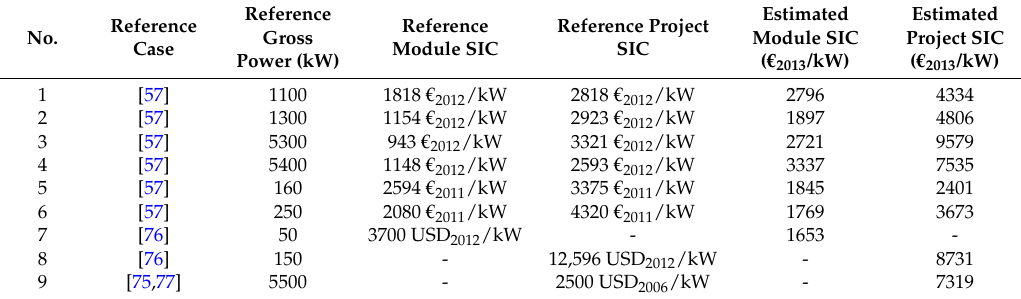
Table 2. Cost estimation using the capacity exponent ratio